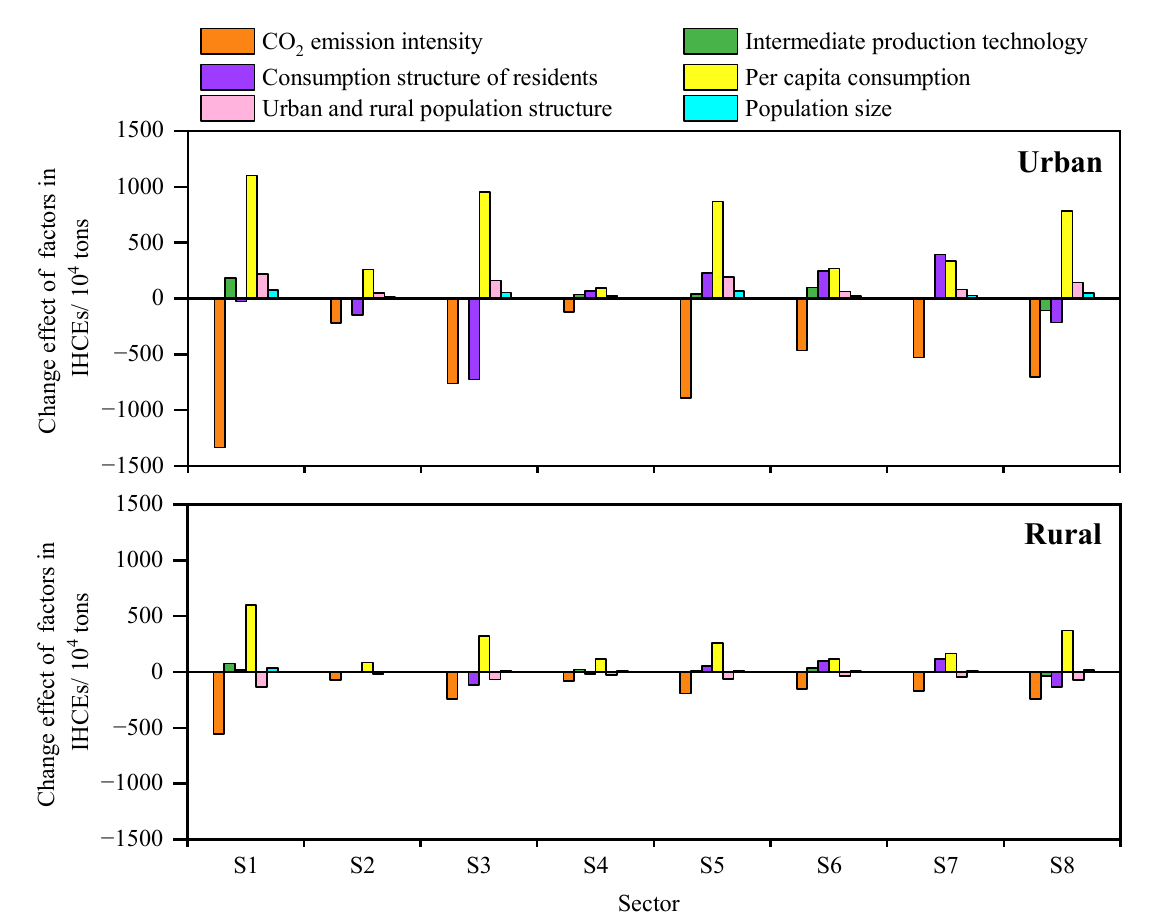
Figure 10. Change effect of influencing factors to IHCEs in Fujian province from 2007 to 2017. Note: S1 is the food sector; S2 is the clothing sector; S3 is the housing sector; S4 is the household equipment and supplies sector; S5 is the transportation and communication sector; S6 is the education and entertainment sector; S7 is the medical care sector; S8 is other goods and services sector.